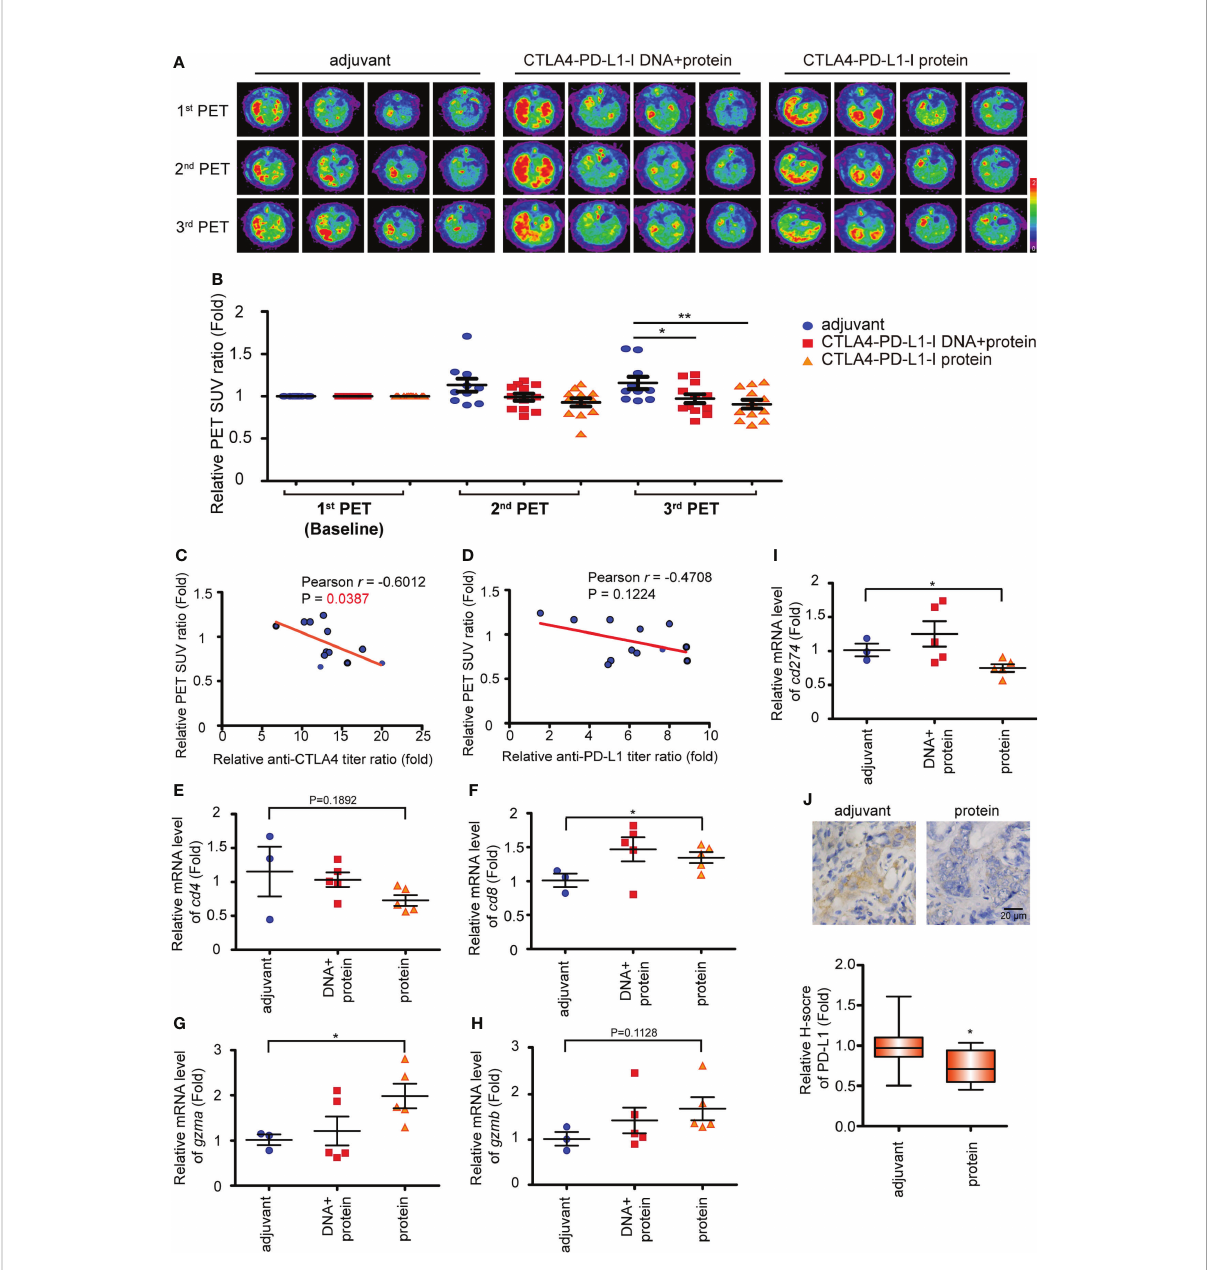
FIGURE 2 The CTLA4-PD-L1-I DNA or protein vaccine repressed rat iCCA tumor growth. (A) Representative image of 18F-FDG microPET on TAA-induced CCA in SD rats. The images were performed before treatment (1 st PET) and after fi ve weeks (2 nd PET) and nine weeks (3 rd PET) of the vaccinations. (B) The change of the tumor-to-liver ratio of the standardized uptake value (SUV) in the control adjuvant and experimental groups at fi ve weeks (2 nd PET) and nine weeks (3 rd PET) after the vaccinations. The values are from two independent experiments and presented as the mean ± SEM. N ≧ 10. *P< 0.05, **P< 0.01 by Student ’ s t -tests. (C, D) The correlation between the anti-CTLA4 (C) or PD-L1 (D) antibody titer ratio and the relative PET SUV ratio. The relative PET SUV ratio from the rats receiving CTLA4-PD-L1-I protein vaccination at nine weeks (3 rd PET). The correlation Pearson coef fi cient r and P values are shown in the panel. N=12. (E-I) The mRNA expression levels of cd4 (E) , cd8 (F) , gzma (G) , gzmb (H) , and cd274 (I) in the tumors from the iCCA-bearing rats receiving a combination of CTLA4-PD-L1-I DNA and protein (DNA + protein), CTLA4-PD-L1-I protein (protein), or control adjuvant. The values (means ± SEM) are presented as the fold-change relative to the average level of the tumors from the rats receiving control adjuvant. N ≧ 3.*P < 0.05 by Student ’ s t -test. (J) Upper: Immunohistochemical staining of PD-L1 in TAA-induced iCCA receiving CTLA4-PD-L1-I protein (protein) or adjuvant. Scale bars: 20 m m. Lower: The values (means ± SEM) are presented as the fold-change relative to the average H score of the tumors from the rats receiving control adjuvant. N ≧ 10.*P < 0.05 by Student ’ s t